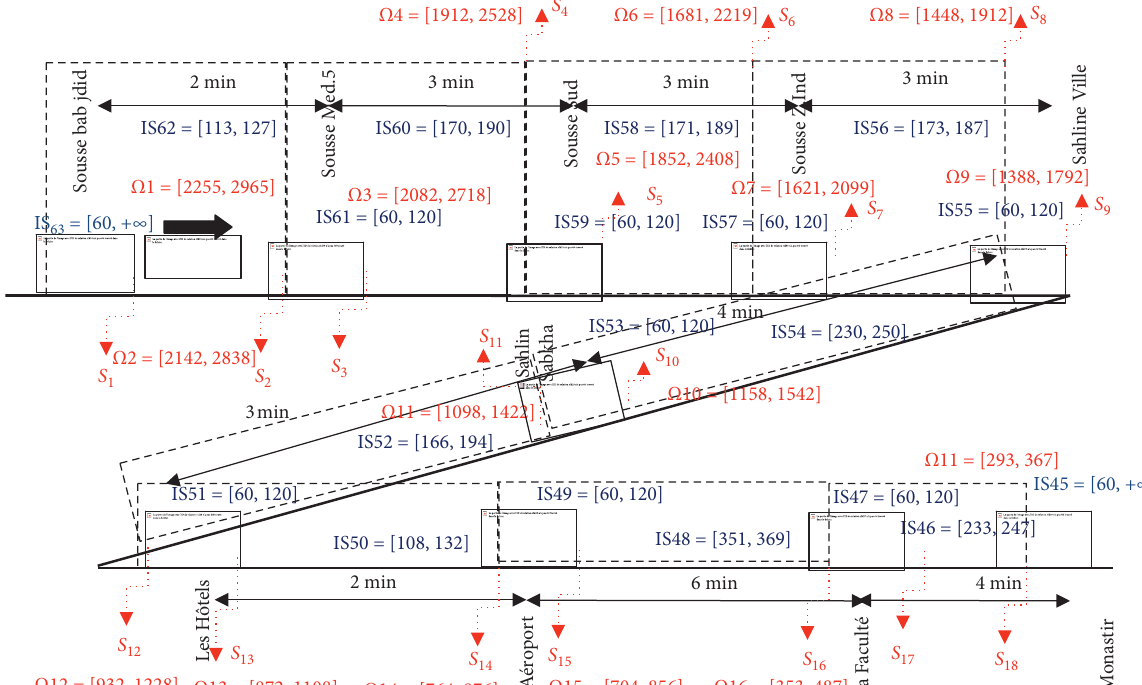
Figure 9: Travel time from Sousse to Monastir